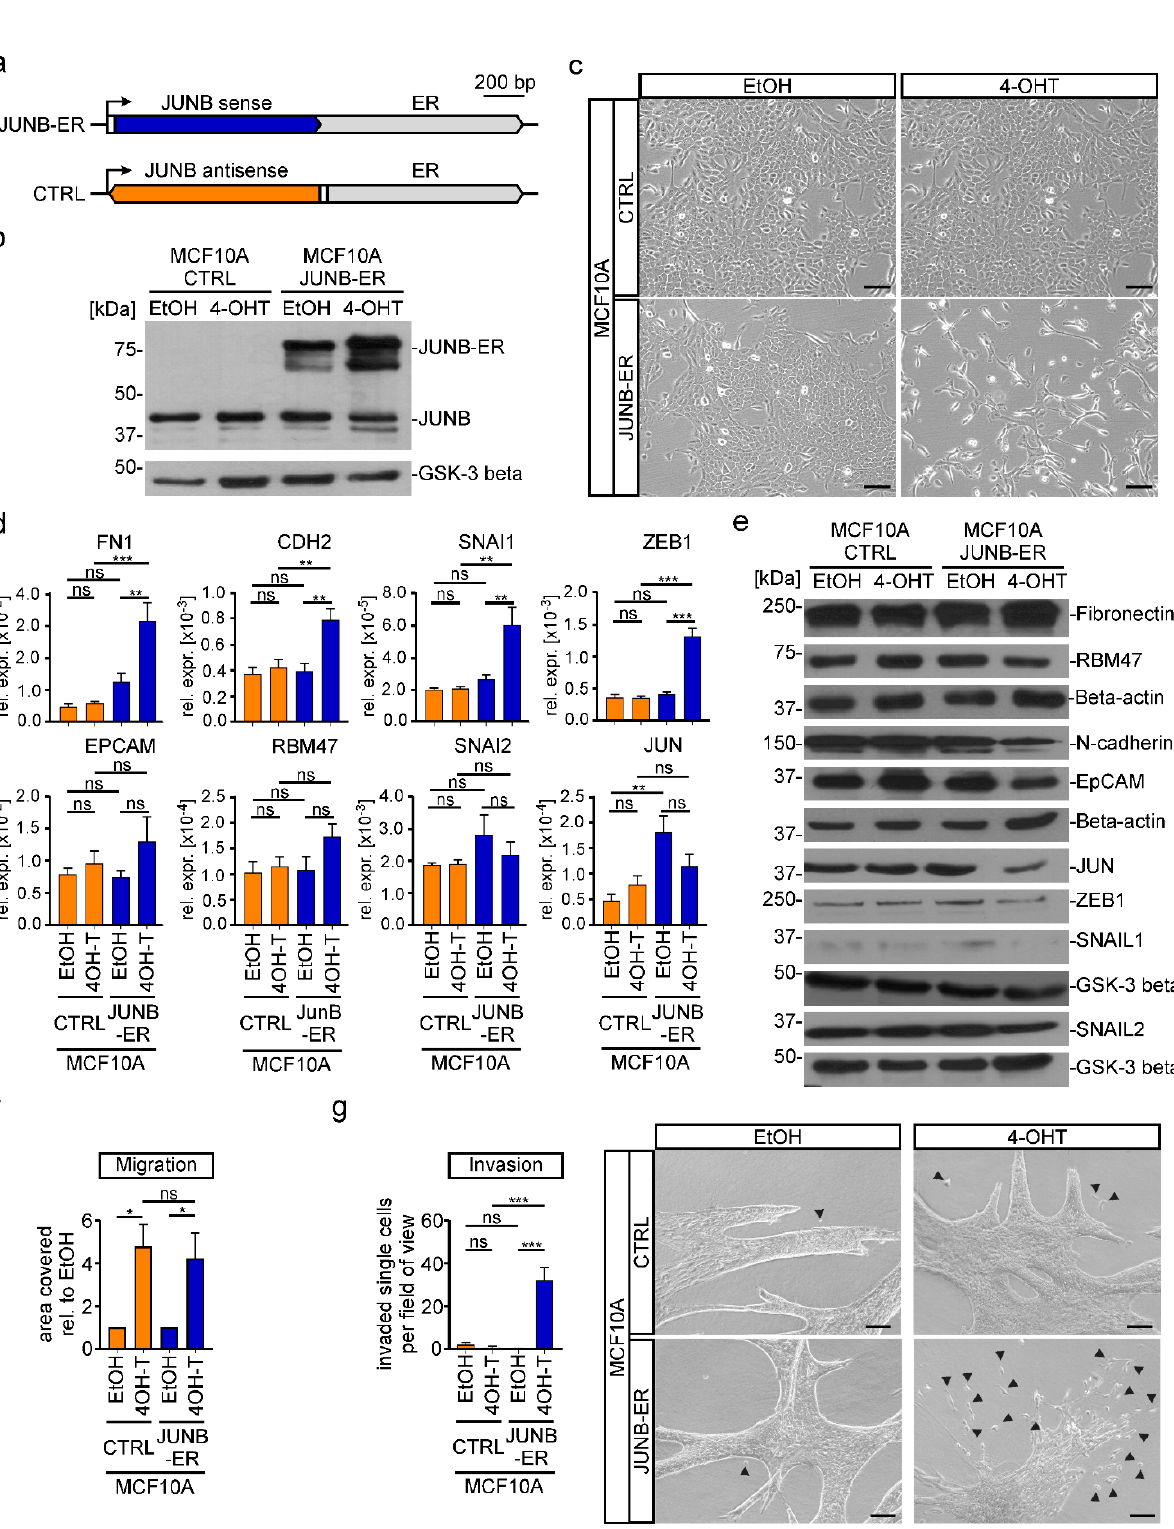
Figure 6. Increased JUNB activity is sufficient to induce EMT in MCF10A cells. ( a ) Schematic representation of the gene expression cassette for a fusion protein consisting of the human JUNB coding region (JUNB sense) and a mutant estrogen receptor hormone binding domain (ER). A control construct (CTRL) harbored the JUNB coding region in opposite orientation (JUNB antisense). The an- gled arrow indicates the TSS; the white box represents the 5 ′ -untranslated region. ( b ) Simultaneous detection of endogenous JUNB und ectopic JUNB-ER expression by Western blot using nuclear ex- tracts from MCF10A cells that had been stably transduced with a retroviral vector for expression of